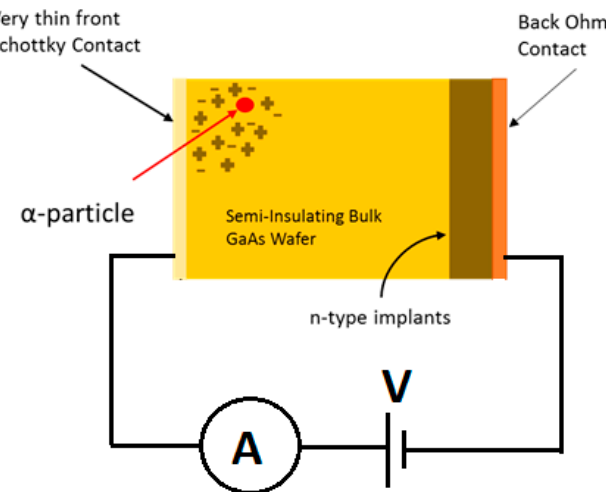
Figure 3. Schematic diagram of GaAs Schottky Barrier Diodes for α -particle detection.